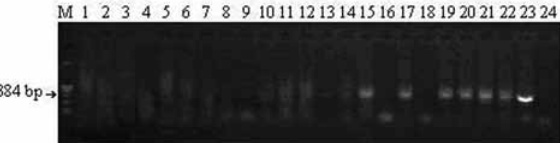
Fig. 2. – Products of amplification of gene fragment encoding β -giardin of G. intestinalis obtained from dnA isolated with protocol 7 B (3x boiling (100 °c/2 min) and freezing in liquid nitrogen (2 min), QiAamp dnA stool kit, QiAGen, incubation with proteinase 56 °c/night) m – marker of molecular masses; paths 1-4 – amplicons obtained from dnA isolate received from 10 cysts; paths 5-8 – amplicons obtained from dnA isolate received from 50 cysts; paths 9-12 – amplicons obtained from dnA isolate received from 100 cysts; paths 13-16 – amplicons obtained from dnA isolate received from 500 cysts; paths 17-20 – amplicons obtained from dnA isolate received from 1,000 cysts; paths 21, 22 and 23 – amplicons obtained from positive controls; path 24 – negative